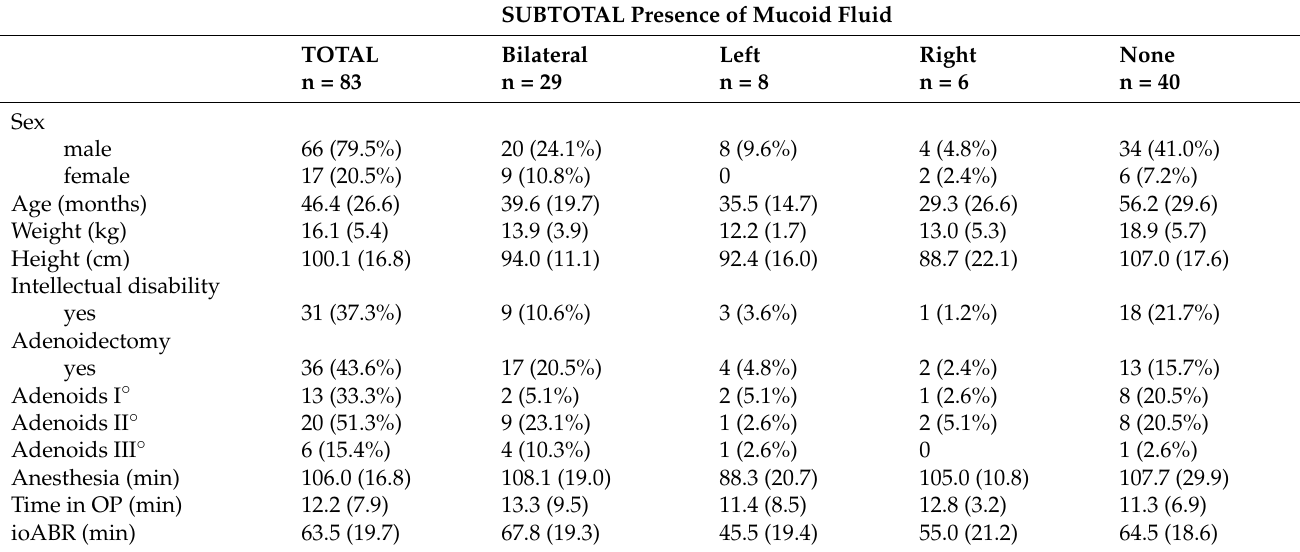
Table 1 summarizes the characteristics of the total study sample and subsamples based on the presence or absence of mucoid fluid. Table 1. Participant characteristics (in percentages and mean and standard